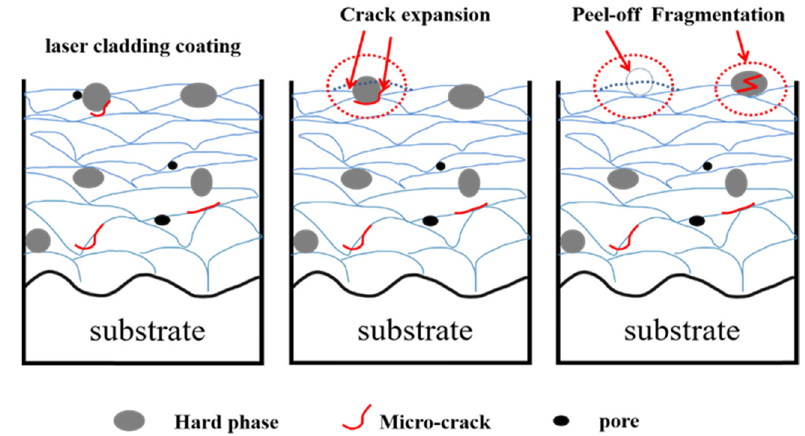
Figure 14: Mechanism diagram of friction and wear